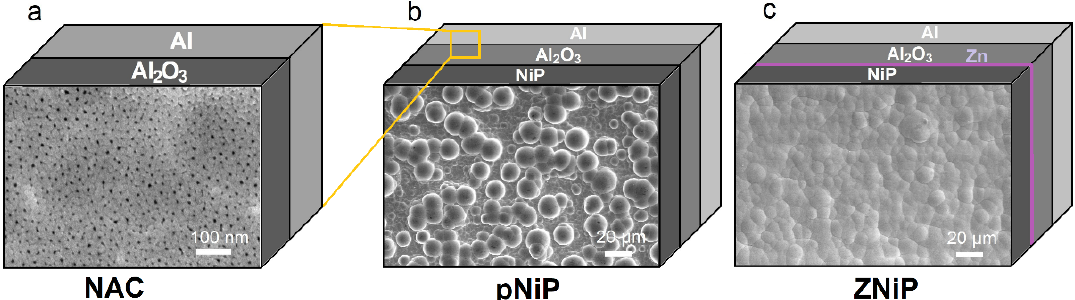
Figure 1. SEM images: ( a ) Nanoporous Al 2 O 3 ceramics (NAC) at larger magnification, ( b ) plain Ni-P (pNiP) deposited on Al 2 O 3 without zincate treatment, ( c ) zincated Ni-P (ZNiP) on Al 2 O 3 with zincate treatment.